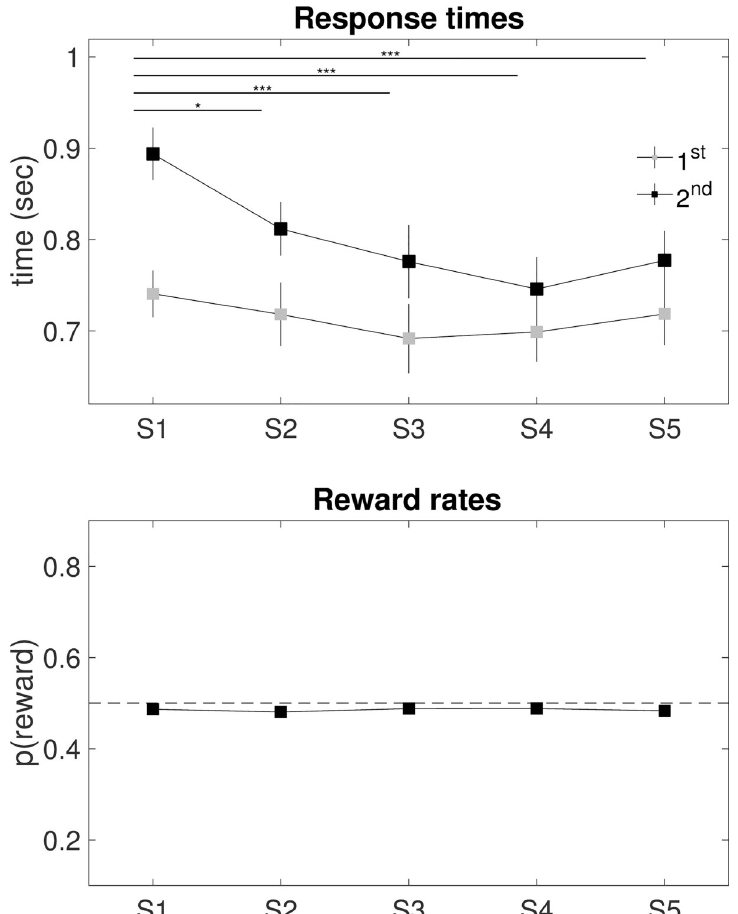
Fig 3. Response times and reward rates. Training effects were observed on 2 nd stage (but not 1 st stage) response times, which were longer in S1 compared to any of S2-S5. No training effect was observed on overall reward rates. Error bars represent standard error of the mean. Dashed horizontal line indicates chance level. See Table 1 for